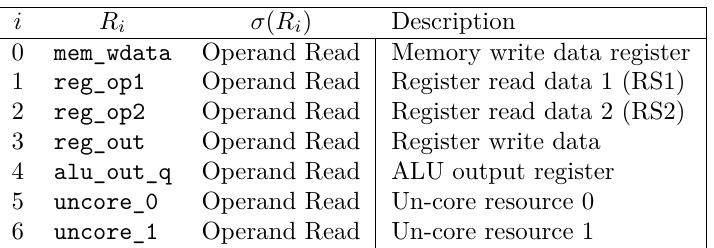
Table 1: A table, for each core, capturing R , the set of micro-architectural resources controlled by FENL . CR